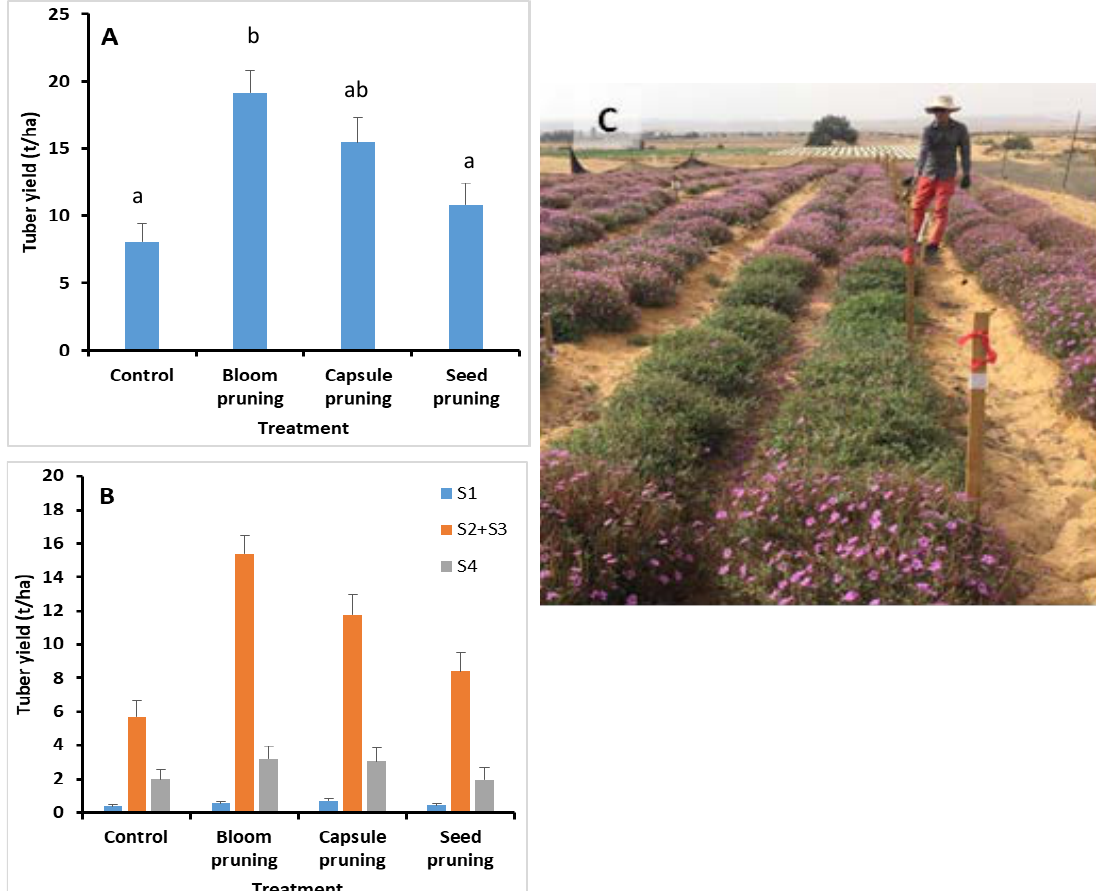
Figure 4. Effects of recurrent pruning of reproductive organs during three consecutive developmental stages: bloom, fruit (capsule) set, and seed formation on the total HSB tuber yield. Different superscript letters indicate significant differences ( A ), and on the distribution of the tubers between fractions according to size, quality, and age ( B ). A picture demonstrating pruning treatments ( C ). Control is without pruning at all. Bars indicate